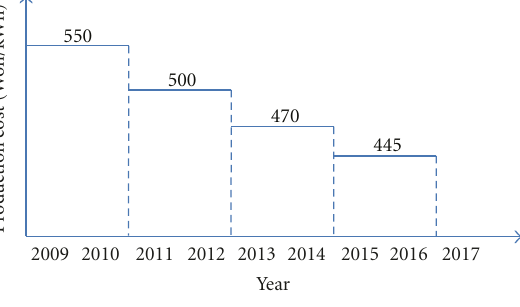
Figure 20: Market price scenario.